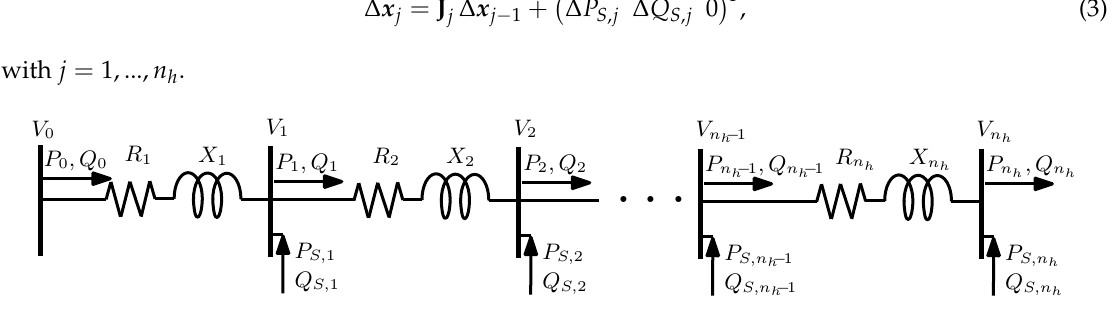
Figure 4. Electric equivalent circuit of the h -th